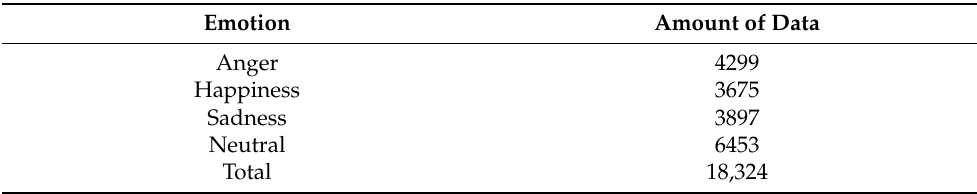
Table 1. The amount of data per emotion category.